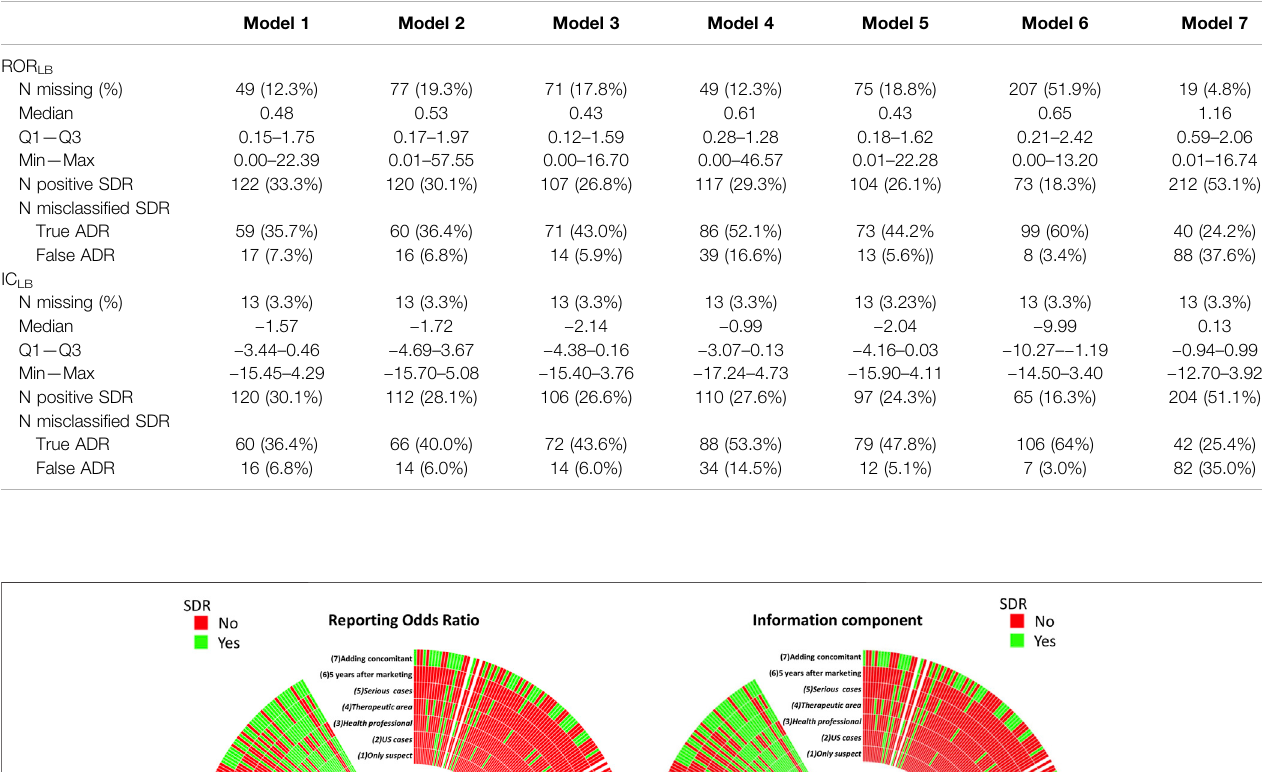
TABLE 1 | Disproportionality analyses and signal generation results for the lower bound of the 95% con fi dence intervals of the reporting odds ratio (ROR LB ) and of the information component (IC LB ) for the seven selected models. SDR: Signal of disproportionate reporting. Model 1: only suspect cases; Model 2: subgroup by country (United States); Model 3: health professionals only; Model 4: subgroup by therapeutic area; Model 5: serious cases only; Model 6: 5 years after drug approval; Model 7: suspected and concomitant drugs.